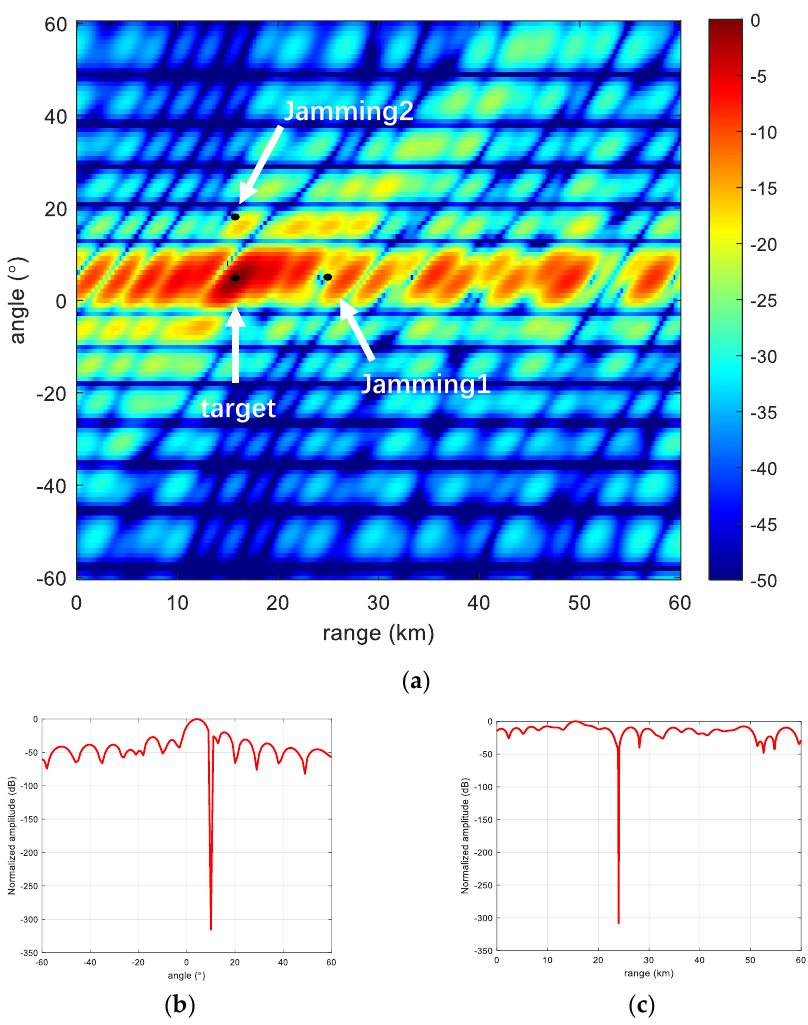
Figure 9. Log-FDA performance. ( a ) Log-FDA; ( b ) Range-dimensional slicing; and ( c ) Angle- dimensional slicing.